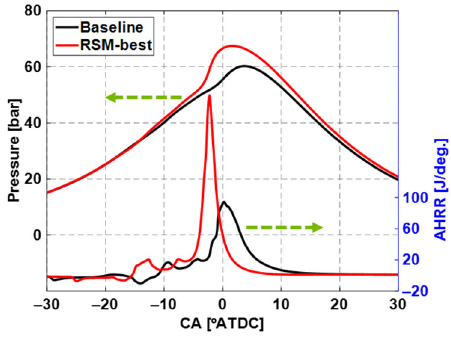
9 of 15 Figure 5. Sample response surfaces of combustion efficiency (η c ) and NO x emissions with respect to SOI 1st and the number of nozzle holes. After identifying the optimal fuel spray pattern and injection strategies, they were validated in the CFD analysis. The best case from RSM optimization (RSM-best) provided good agreement against the CFD analysis results. The relative errors between the RSM- predicted and CFD-simulated combustion efficiency (ŋ c ) and NO x emissions were small (0.5% in ŋ c and 1.6% in NO x ). Table 6 compares the baseline case and the RSM-best case (CFD validated) in terms of design and objective variables. The RSM-best case showed a 17 percentage point improvement in combustion efficiency (ŋ c ) at the cost of a moderate increase in NO x compared to the baseline case. The merit value in the RSM-best case was also much larger than that in the baseline case. Figure 6 presents a comparison of the global combustion characteristics between the baseline and optimized cases. The RSM- best case clearly had a higher peak in-cylinder pressure, a stronger apparent heat release rate (AHRR), a more advanced start of combustion (SOC), and a shorter combustion du- ration, contributing to enhanced combustion efficiency, as shown in Table 6. Table 6. Comparison of baseline and RSM-best performance cases. Design Variables